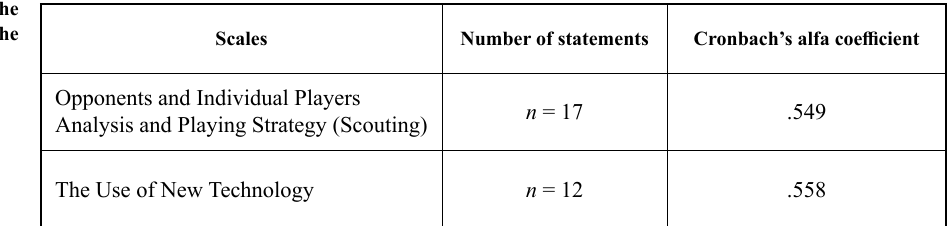
Table. The criteria for the internal consistency of the scales